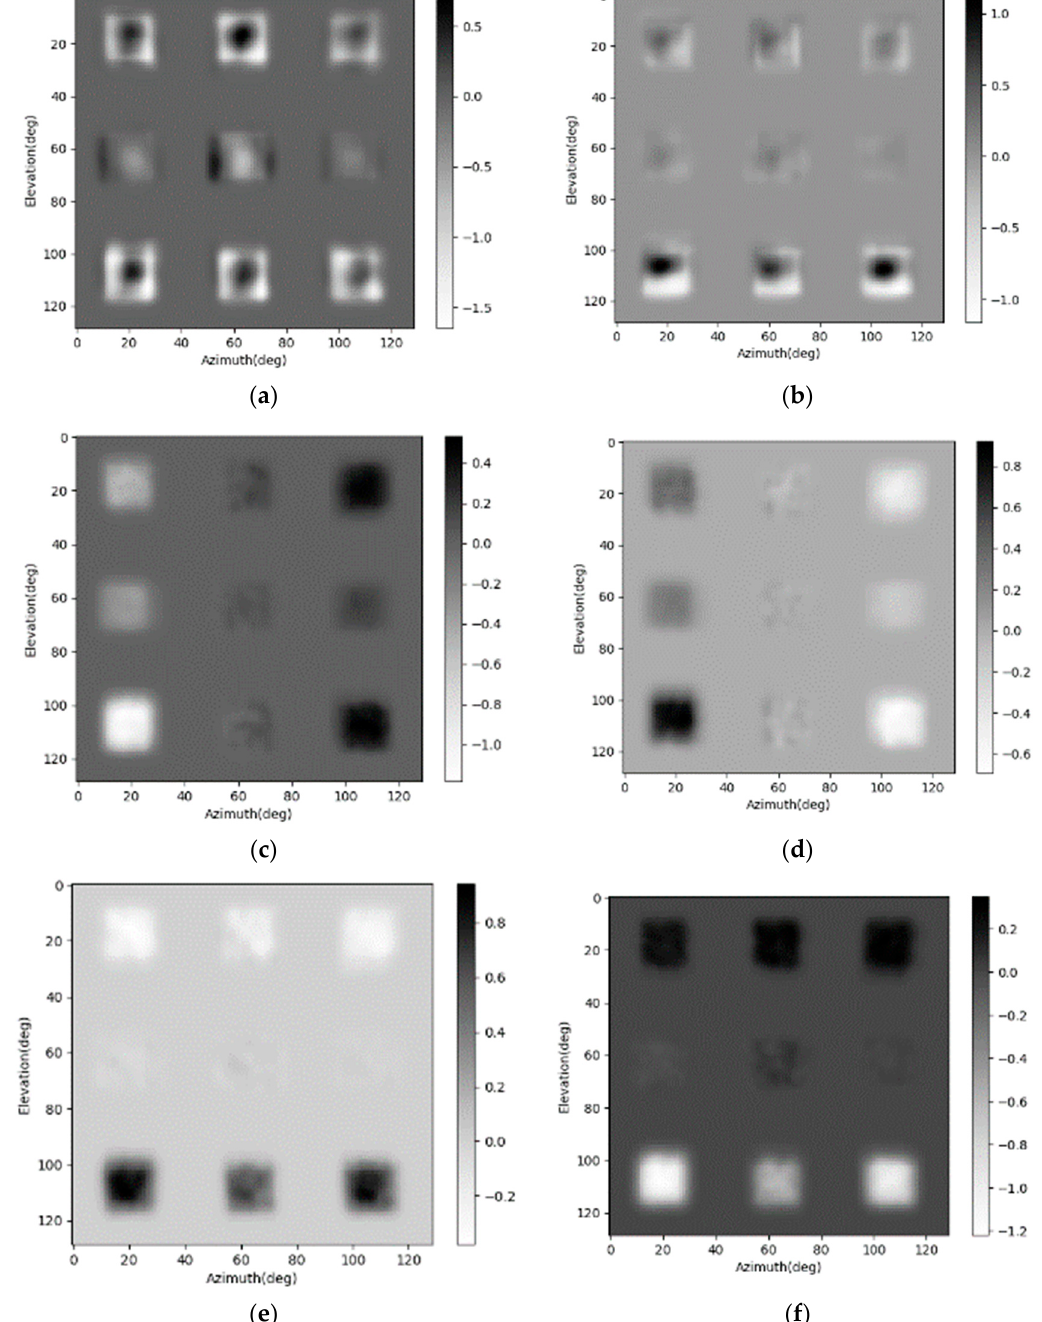
Figure 9. Guided backpropagation results on each channel of the sample. ( a ) Results on the 1st channel; ( b ) results on the 2nd channel; ( c ) results on the 3rd channel; ( d ) results on the 4th channel; ( e ) results on the 5th channel; ( f ) results on the 6th channel.